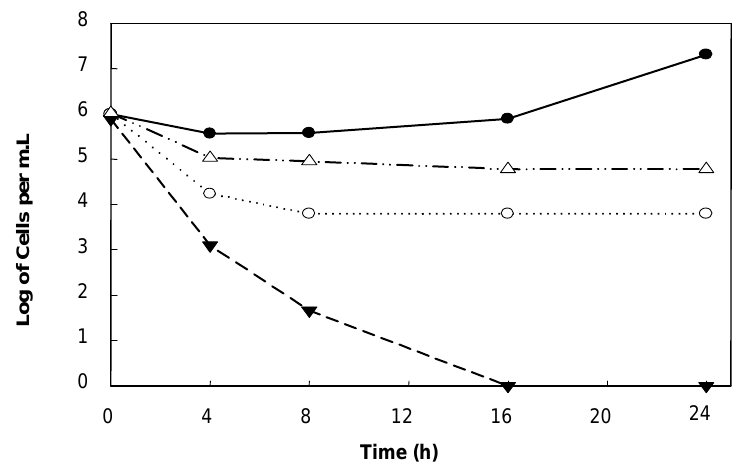
Figure 4. Effect of 0.02% ( ● ), 0.07% ( ○ ), 0.1% ( ▼ ) (v/v) limonene on viability of suspended S. cerevisiae compared to 0.054% limonene ( ∆ ) on the encapsulated